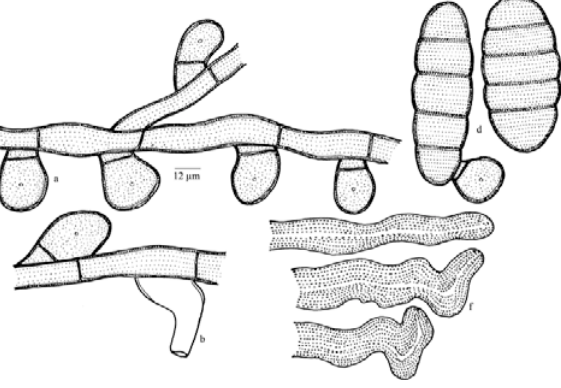
Figure 32. Irenopsis triumfettae var. indica a - Appressorium; b - Phialide; f - Apical portion of the perithecial setae; d -